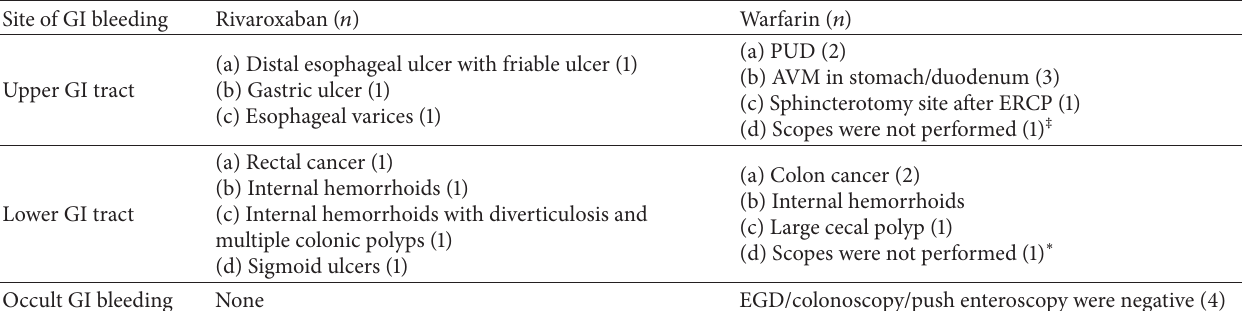
Table 4: Site of GI bleeding.